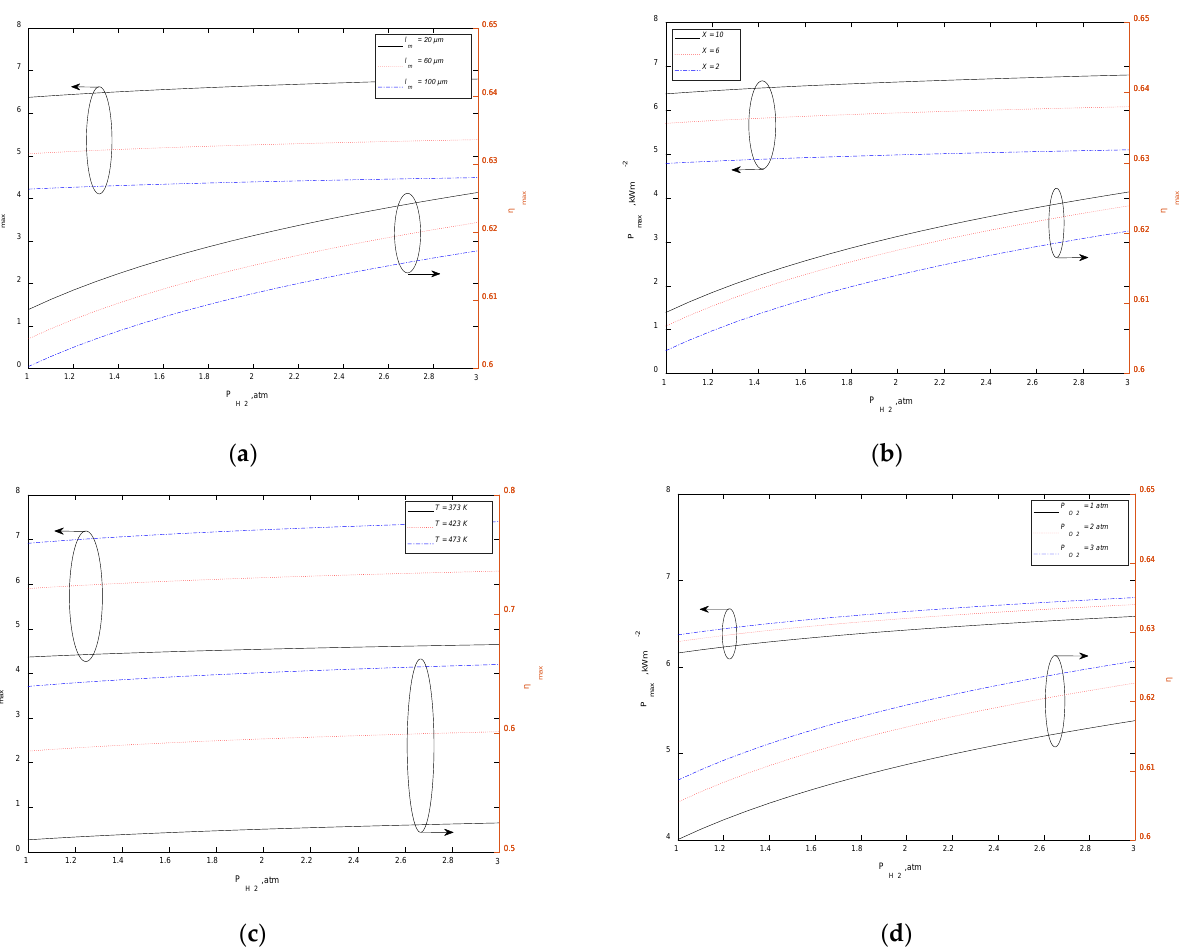
and of HT-PEMFC under different parameters. ( a ) Different . 𝑃𝑃 𝑚𝑚𝑚𝑚𝑚𝑚 𝜂𝜂 𝑚𝑚𝑚𝑚𝑚𝑚 𝑝𝑝 𝑂𝑂 2